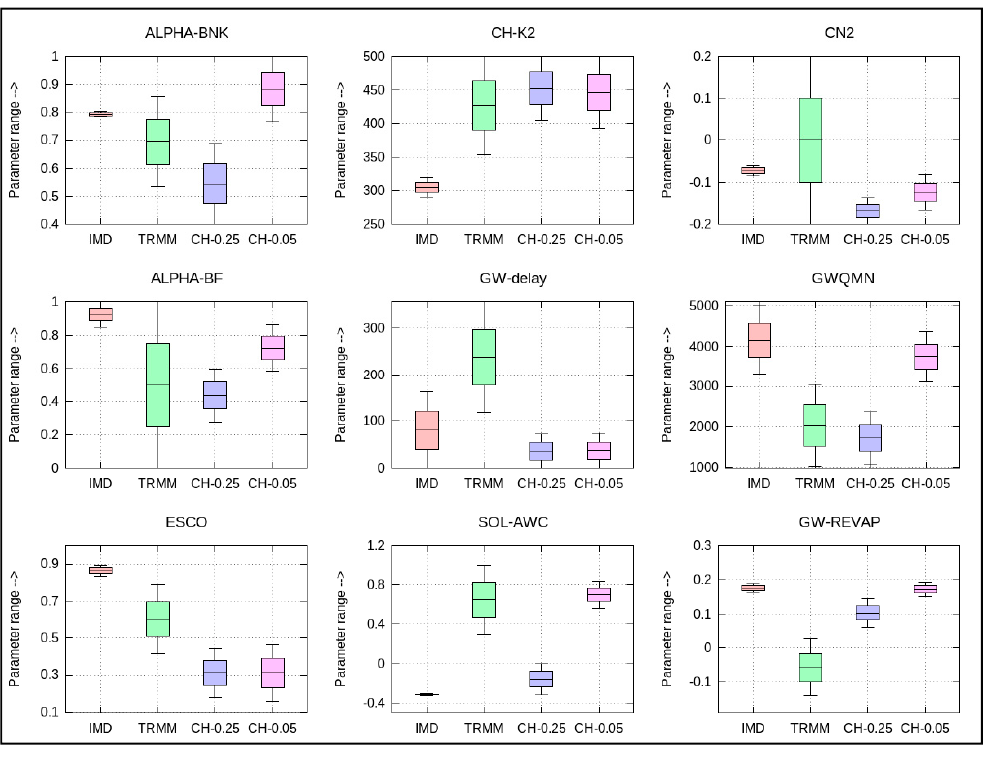
Figure 5. Distribution of the sensitive parameter values using four rainfall datasets.